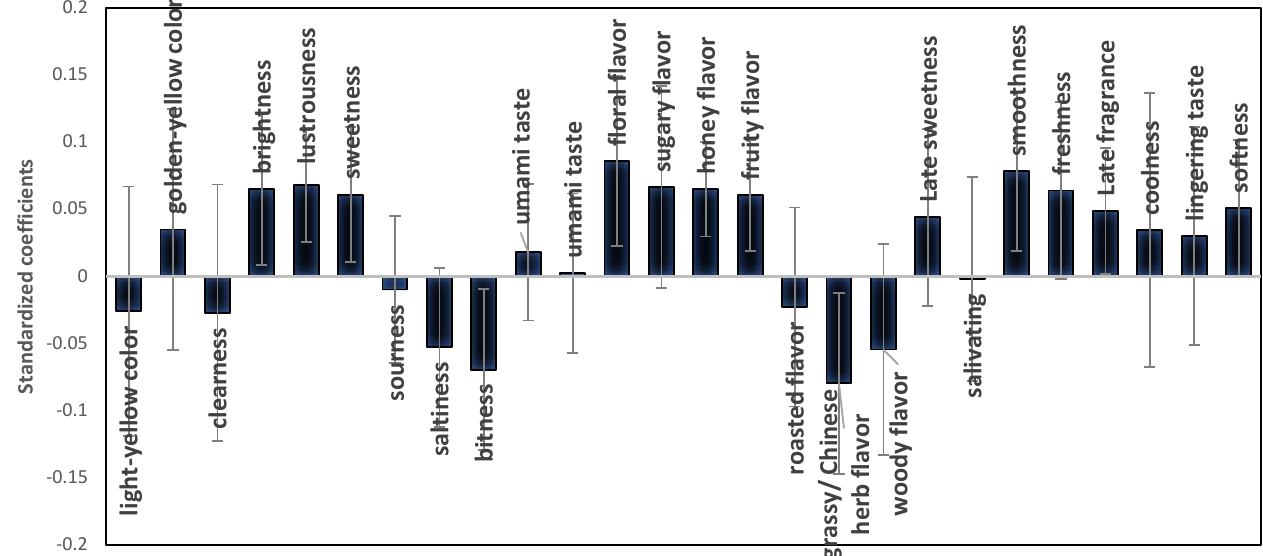
Figure 8. The standardized coefficient between sensory, association, postprandial perception attributes and overall liking of 12 Taiwanese GABA Oolong teas by partial least square (PLS) method.